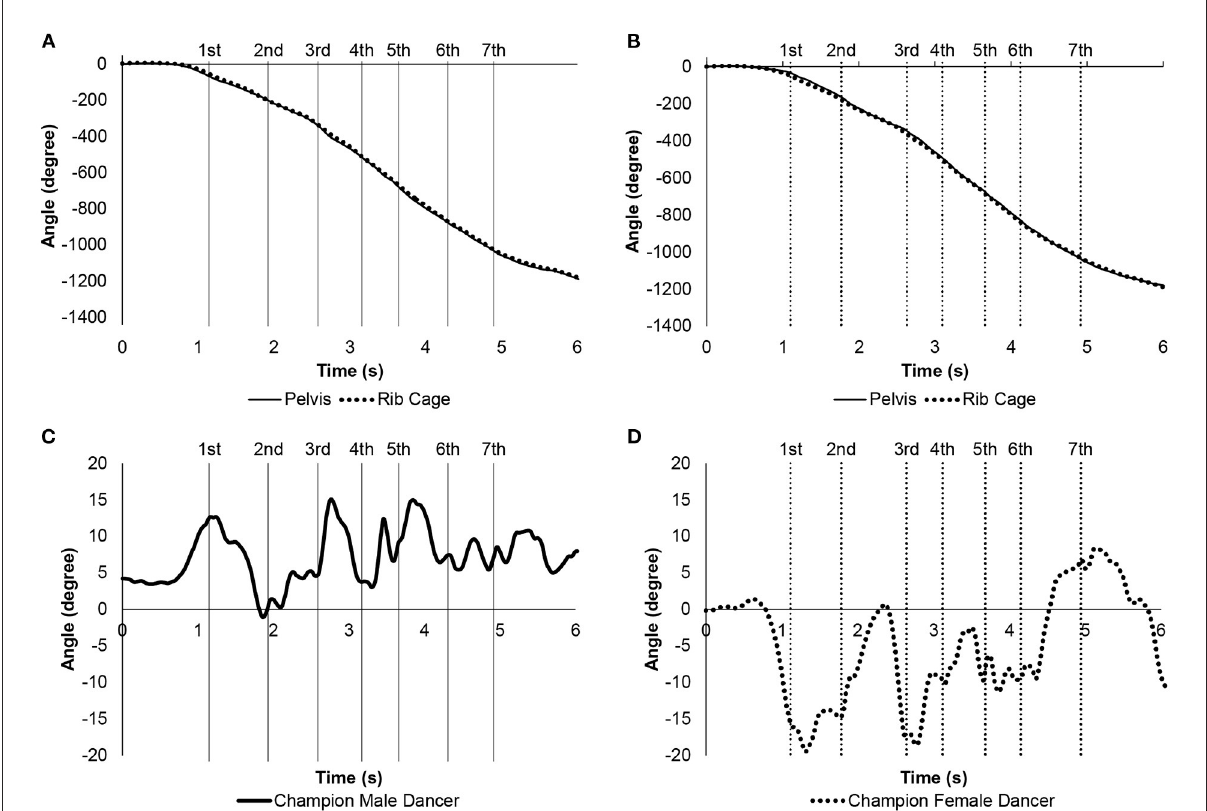
FIGURE3 Euler angles of pelvic and rib cage segments in vertical axis for the champion male and female dancers. The vertical line is the timing when the maximum value of each step for the champion male and female dancers is reached, and solid line is male and dotted line is female. (A) Angles of the champion male dancer. Solid line is pelvic segment. Dotted line is rib cage segment. (B) Angles of the champion female dancer. Solid line is pelvic segment. Dotted line is rib cage segment. (C) Relative angles of the rib cage segment with respect to the pelvic segment for the champion male dancer. Positive values at the relative angles indicated that the rib cage segment rotates to the left and negative values rotate to the right with respect to the pelvic segment. (D) Relative angles of the rib cage segment with respect to the pelvic segment for the champion female dancer. Positive values at the relative angles indicated that the rib cage segment rotates to the left and negative values rotate to the right with respect to the pelvic